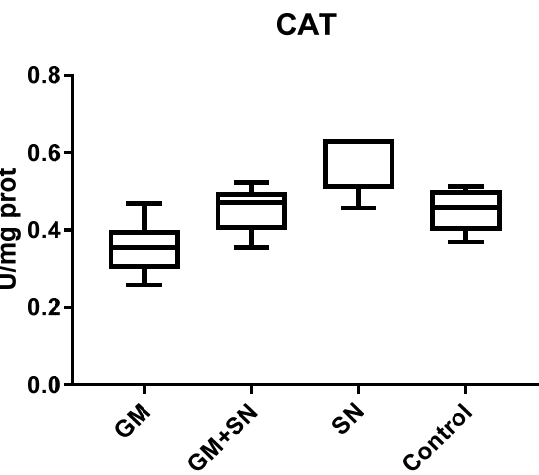
Figure 5. Catalase (CAT) level in the investigated groups. GM—gentamicin group, GM+SN—gentamicin and Sambucus nigra group, SN— Sambucus nigra group, Control—control group (no treatment).